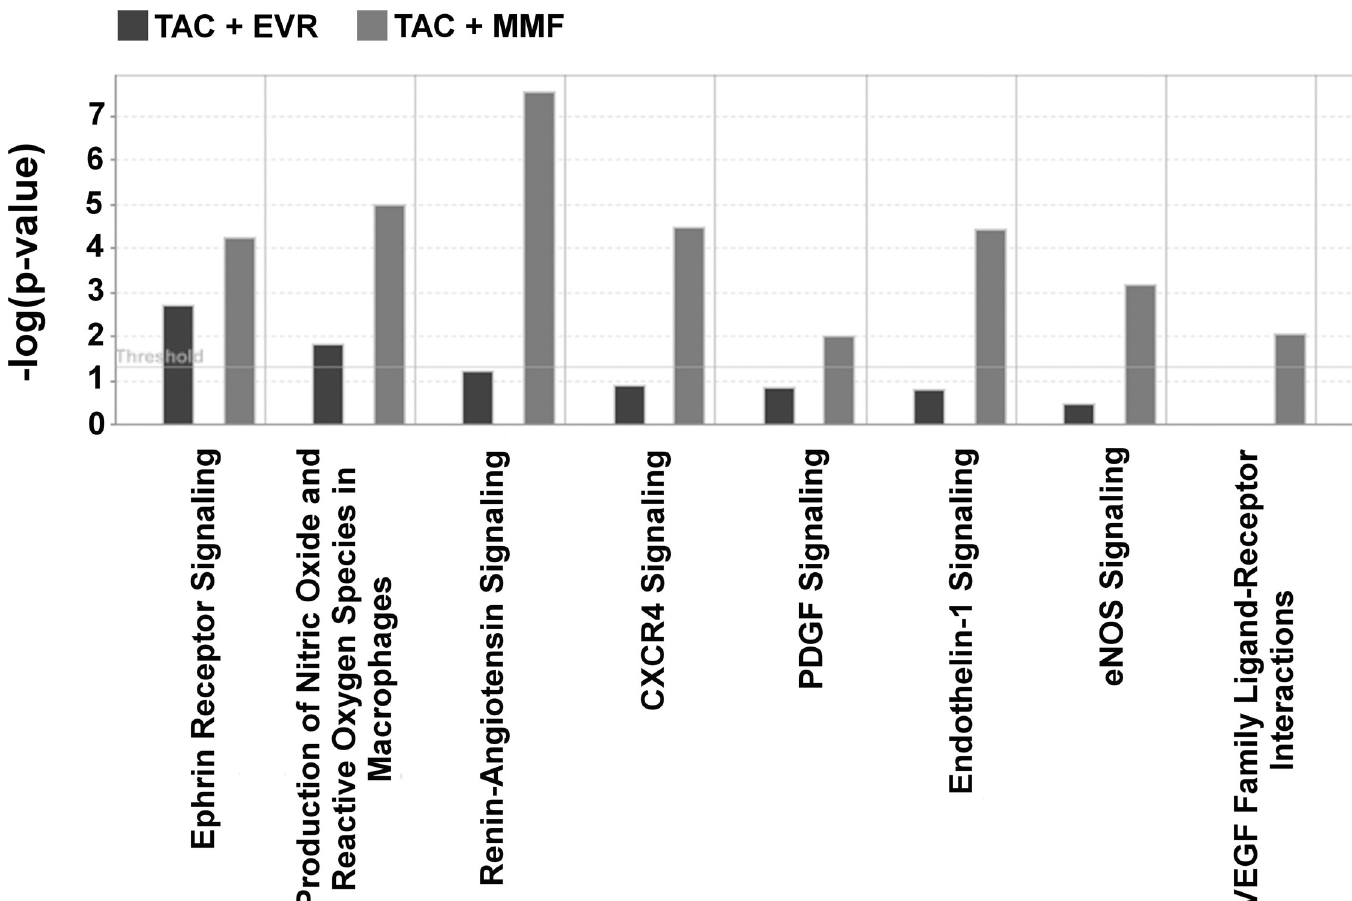
Fig 8. Analysis of time dependent changes in gene expression pathways in TAC+EVR and TAC+MMF groups. Based on comparison analysis of differentially expressed genes at 12 month in comparison to 3 months post-transplantation on the two studied groups, it was observed that pathways related to cell proliferation, chemotaxis and inflammation were much pronounced in TAC+MMF (grey) in comparison to TAC+EVR (black). Please see Tables J and K in S5 File for complete information.